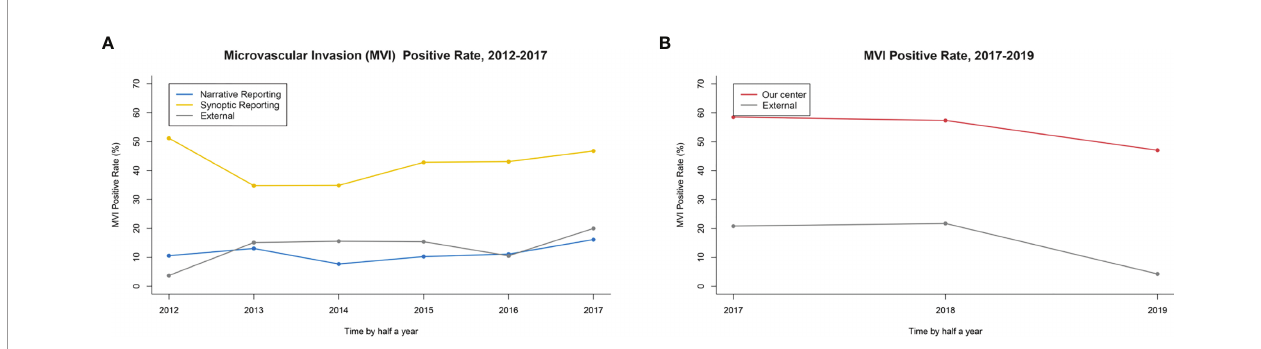
FIGURE 3 | (A) The MVI rate in retrospective study: Synoptic Reporting recommended by the College of American Pathologists (SR-CAP) in the primary group vs. NR in the primary and external group. (B) The MVI rate in the prospective study: Our Center vs. External Center.